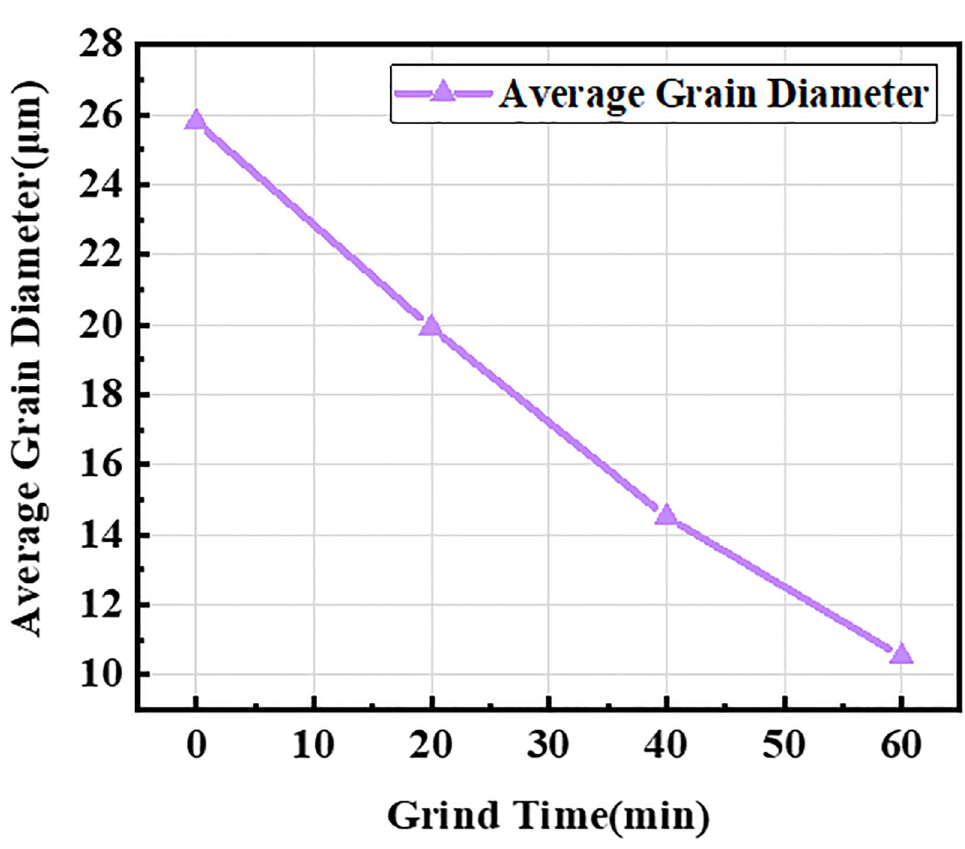
Fig 3. Relationship between grinding time and average particle size of fly